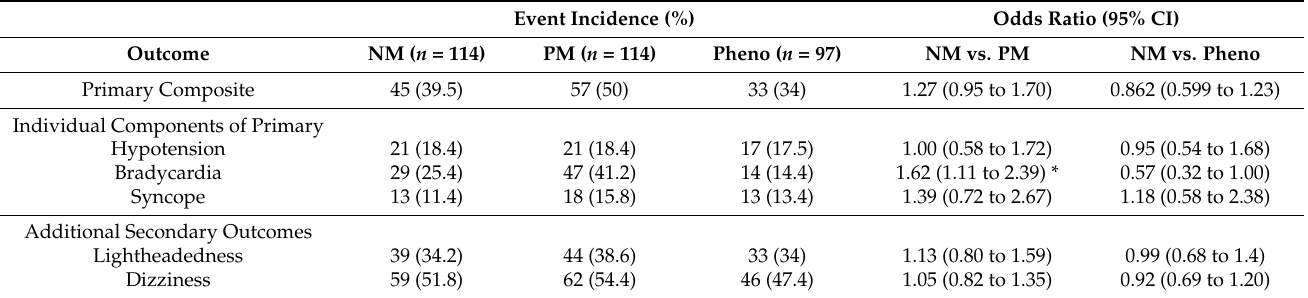
Figure 3. Incidence of bradycardia among CYP2D6 phenotypes stratified by age.